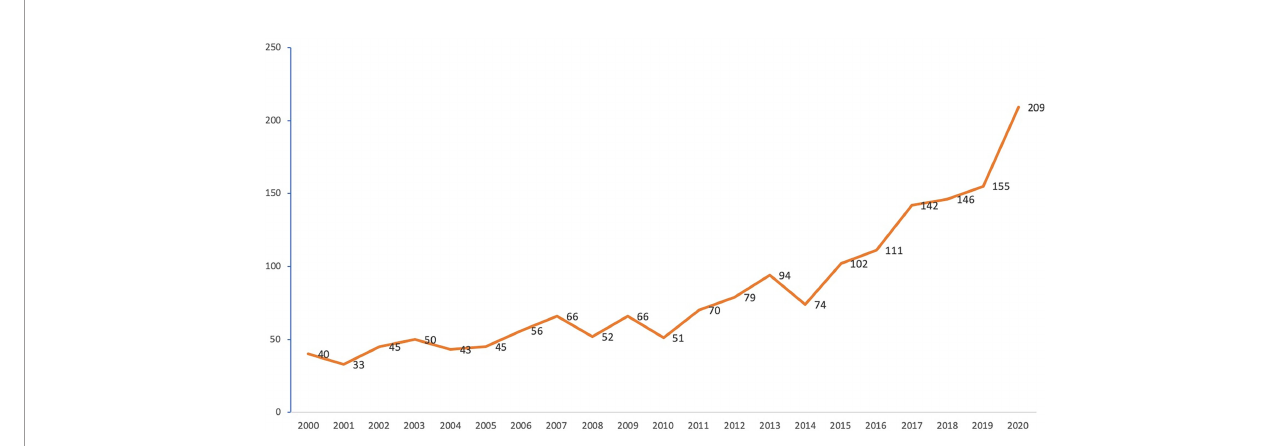
FIGURE 2 | Annual publication number in the fi eld of ovarian cancer